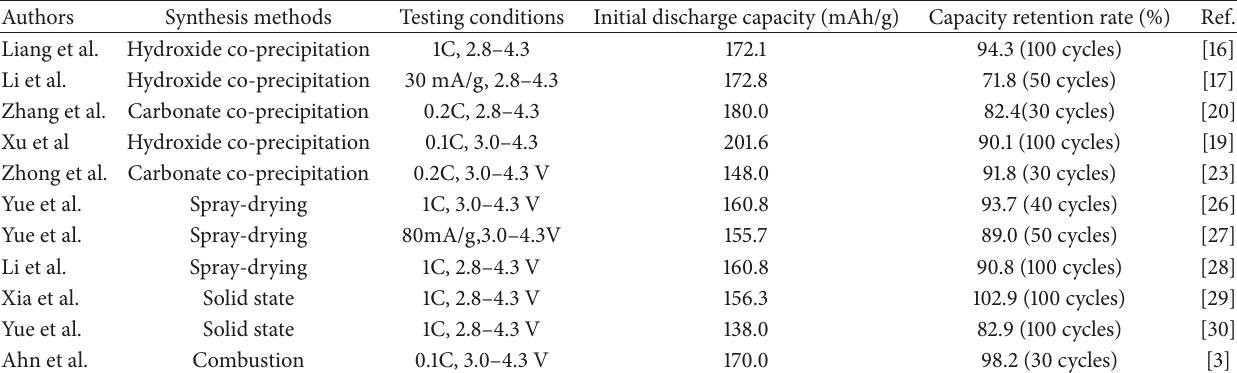
Table 2: Electrochemical performance of